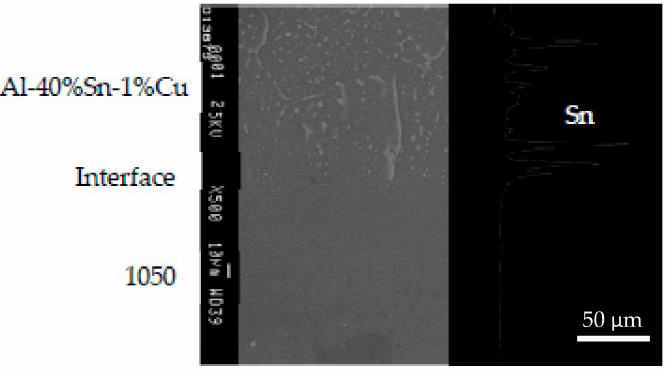
Figure 27. Result of the line analysis of Sn at the interface between the 1050 base strip and the Al-40%Sn-1%Cu overlay strip.